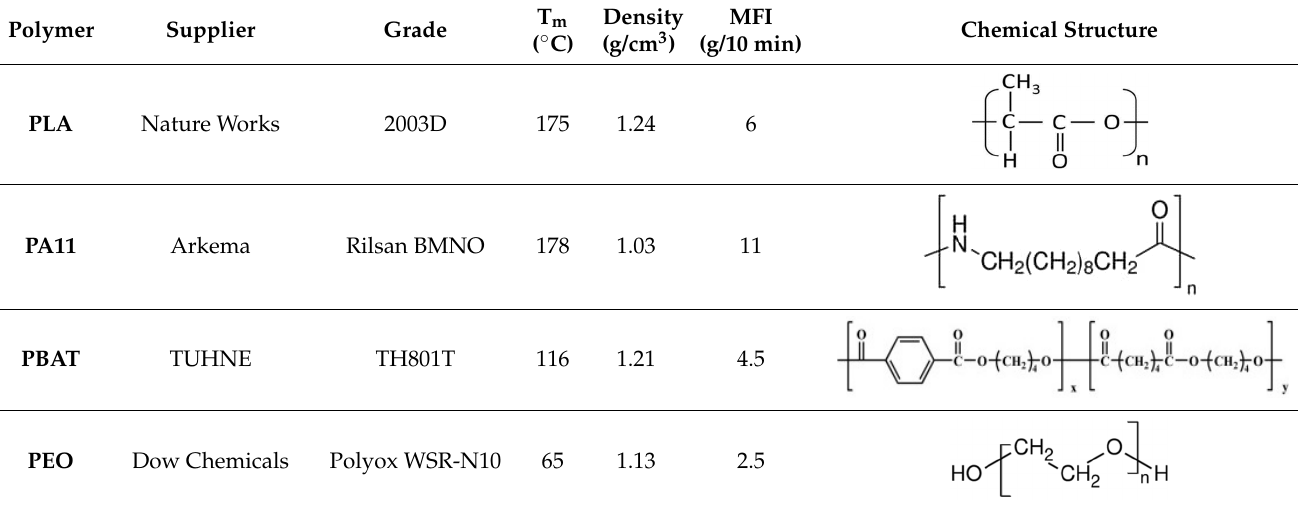
Table 3. Main characteristics of the materials used.